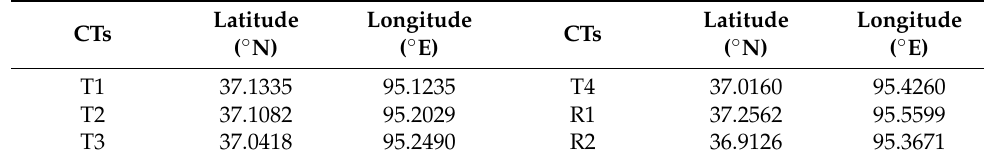
Table 1. Latitude and longitude coordinates of the representative CTs.